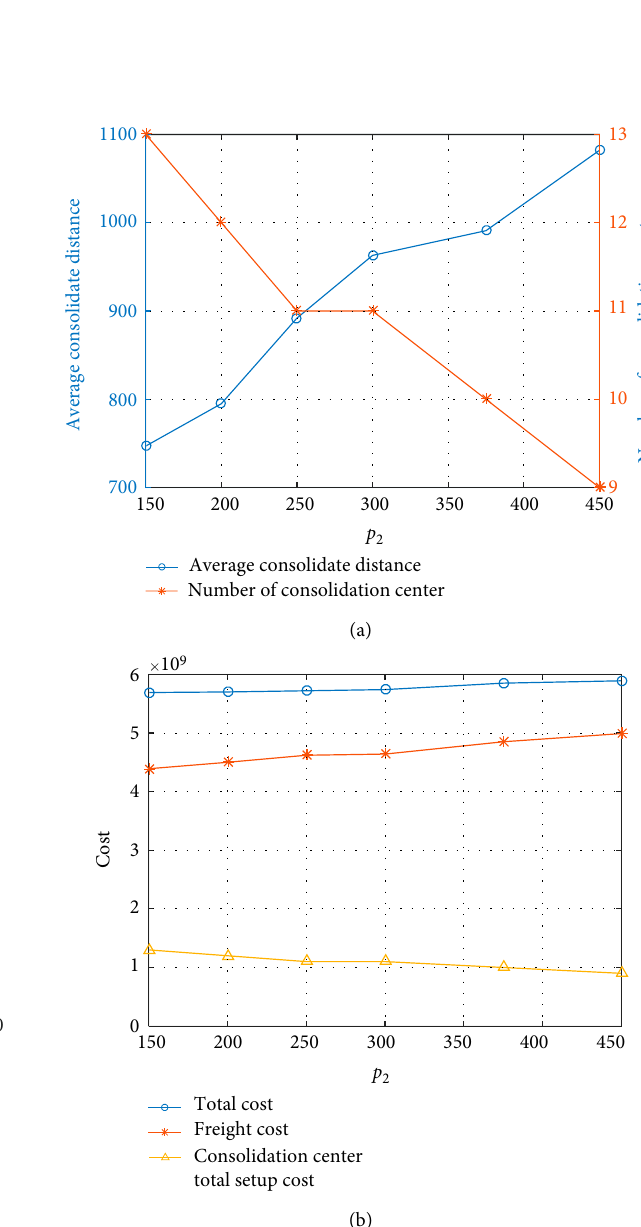
Figure 12: Impacts of freight cost before consolidation ( the average consolidation distance and number of consolidation centers, and (b) the total cost ( center setup cost.